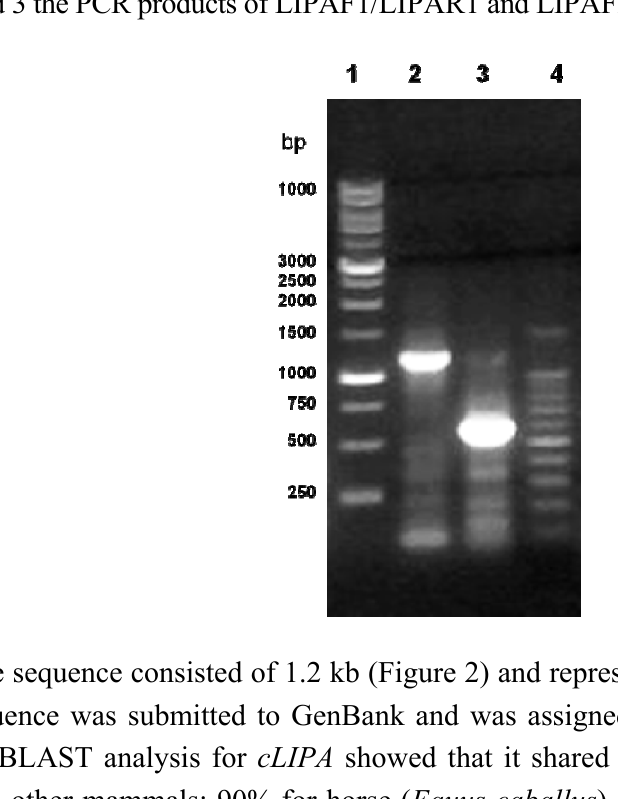
Figure 1. Agarose gel electrophoresis (1.2%) of the PCR products of C. dromedarius cLIPA. Lanes 1 and 4 contain 1kb and 100 bp DNA molecular weight markers, respectively, lanes 2 and 3 the PCR products of LIPAF1/LIPAR1 and LIPAF2/LIPAR2,